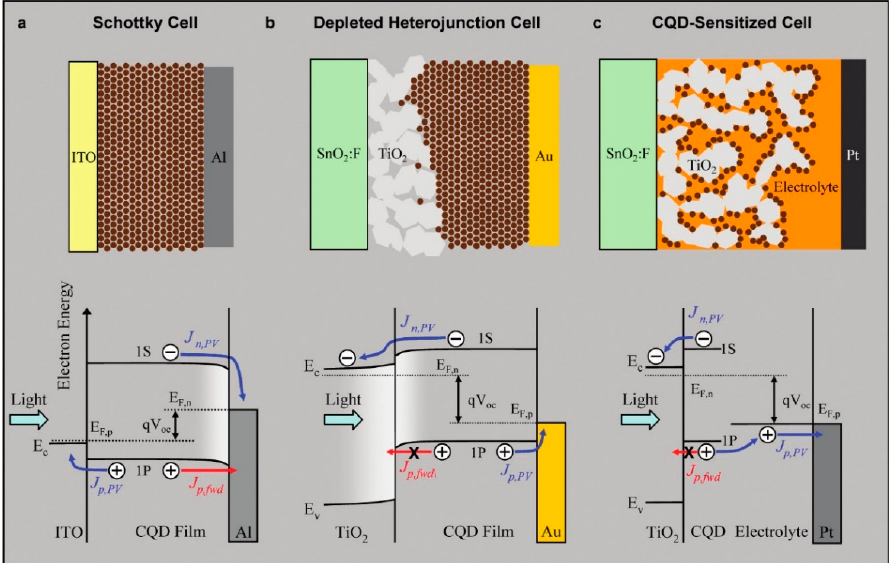
Figure 2. Comparison of three CQD photovoltaic architectures under photovoltaic operation close to maximum V oc . ( a ) The Schottky design has lower FF and V oc for a given J sc , due to the poor barrier for hole injection into the electron-extracting contact; ( b ) the depleted heterojunction design combines the advantages of the other two cells, leading to simultaneously maximized FF , V oc , and J sc ; ( c ) the CQD sensitized cell employs a thin layer of absorber on a high surface area electrode. The light absorbing capacity of this design is lower, leading to poor J sc , while it provides good FF and V oc . E F,n and E F,p are the electron and hole quasi-Fermi levels; E c and E v are the conduction and valence band edges; J p ,PV and J n,PV are the hole and electron photocurrents (and are equal at steady state); J p,fwd is the hole current in the forward bias direction. Reprinted with permission from [35]. Copyright 2013 American Chemical Society.